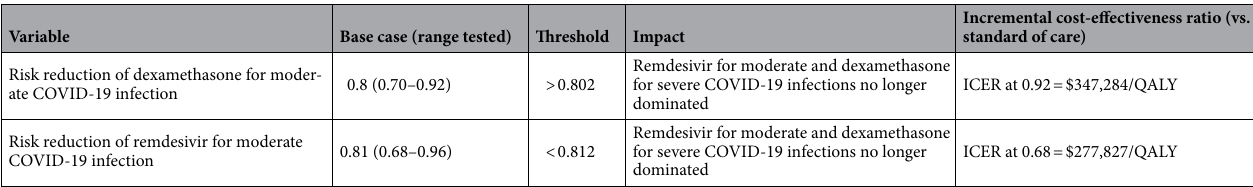
Table 3. Univariate sensitivity analysis thresholds.